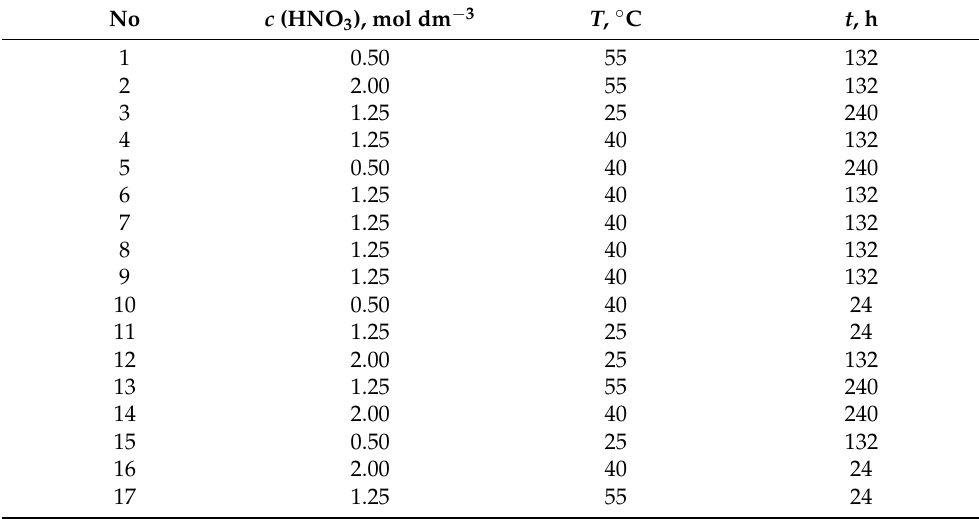
Table 3. Experimental plan according to the Box–Behnken design.